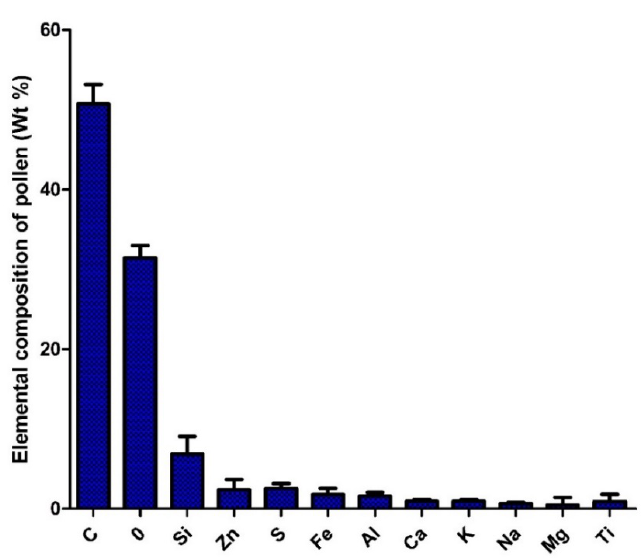
Figure 12. Pollen grain collected in Aguascalientes by CAFs.